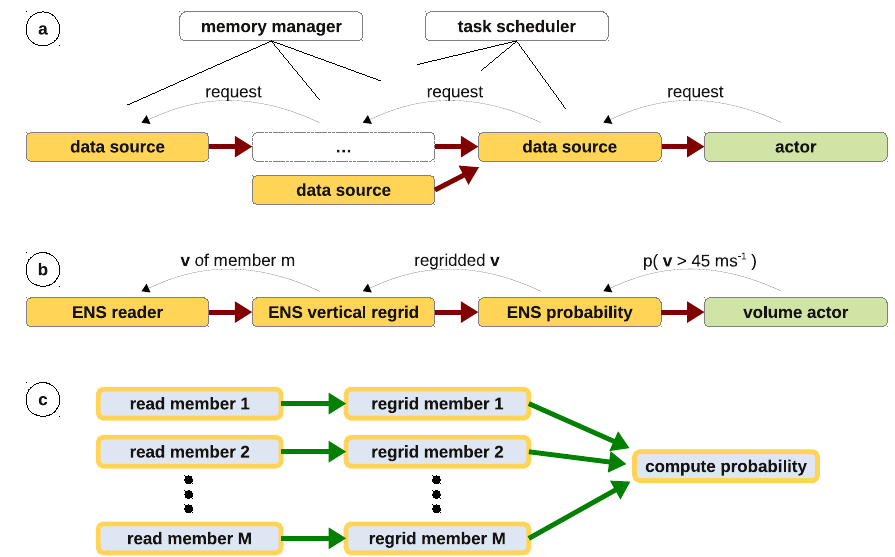
Figure 10. Pipeline concept of Met.3D: (a) data sources are connected to form a pipeline, into which a visualization “actor” sends data requests; (b) sample pipeline to visualize the probability of horizontal wind speed exceeding 45ms − 1 . A request for the probability triggers further requests up the pipeline; (c) Task graph generated by the pipeline in (b) .